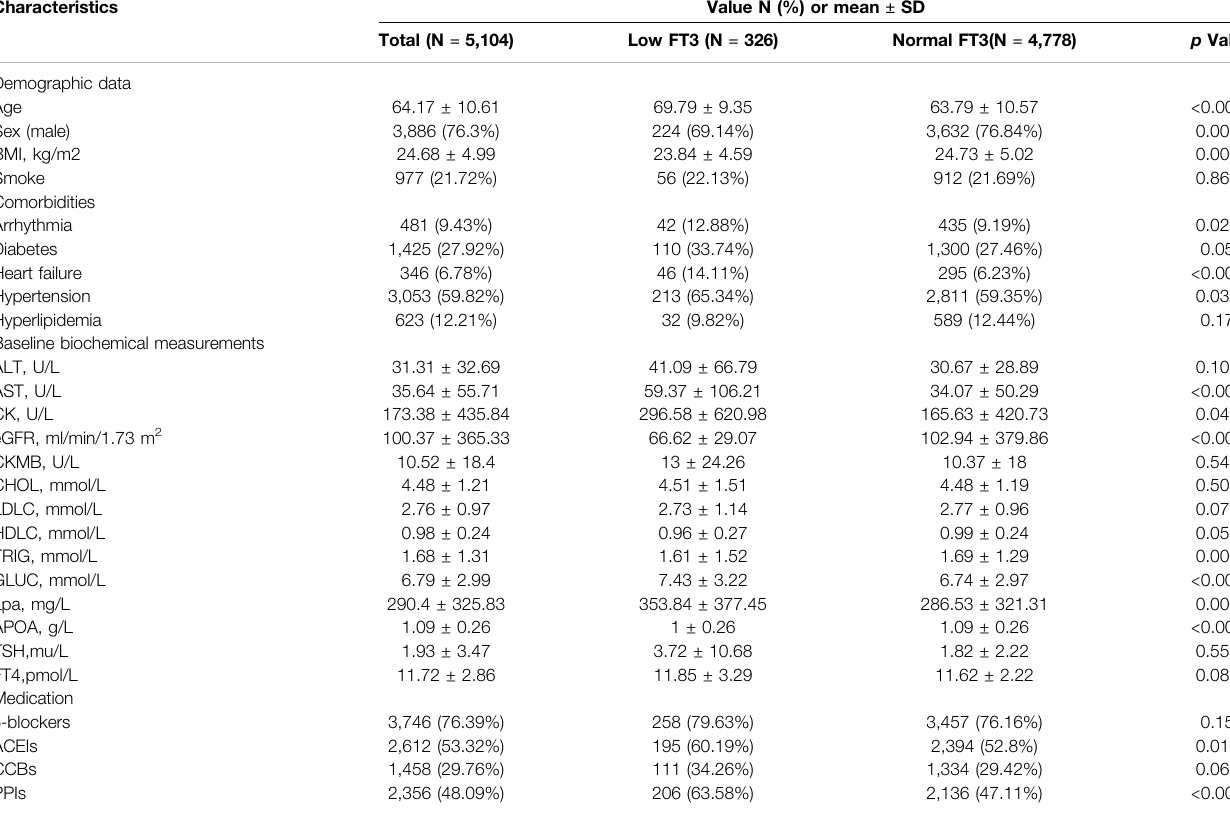
TABLE 1 | Baseline characteristics.